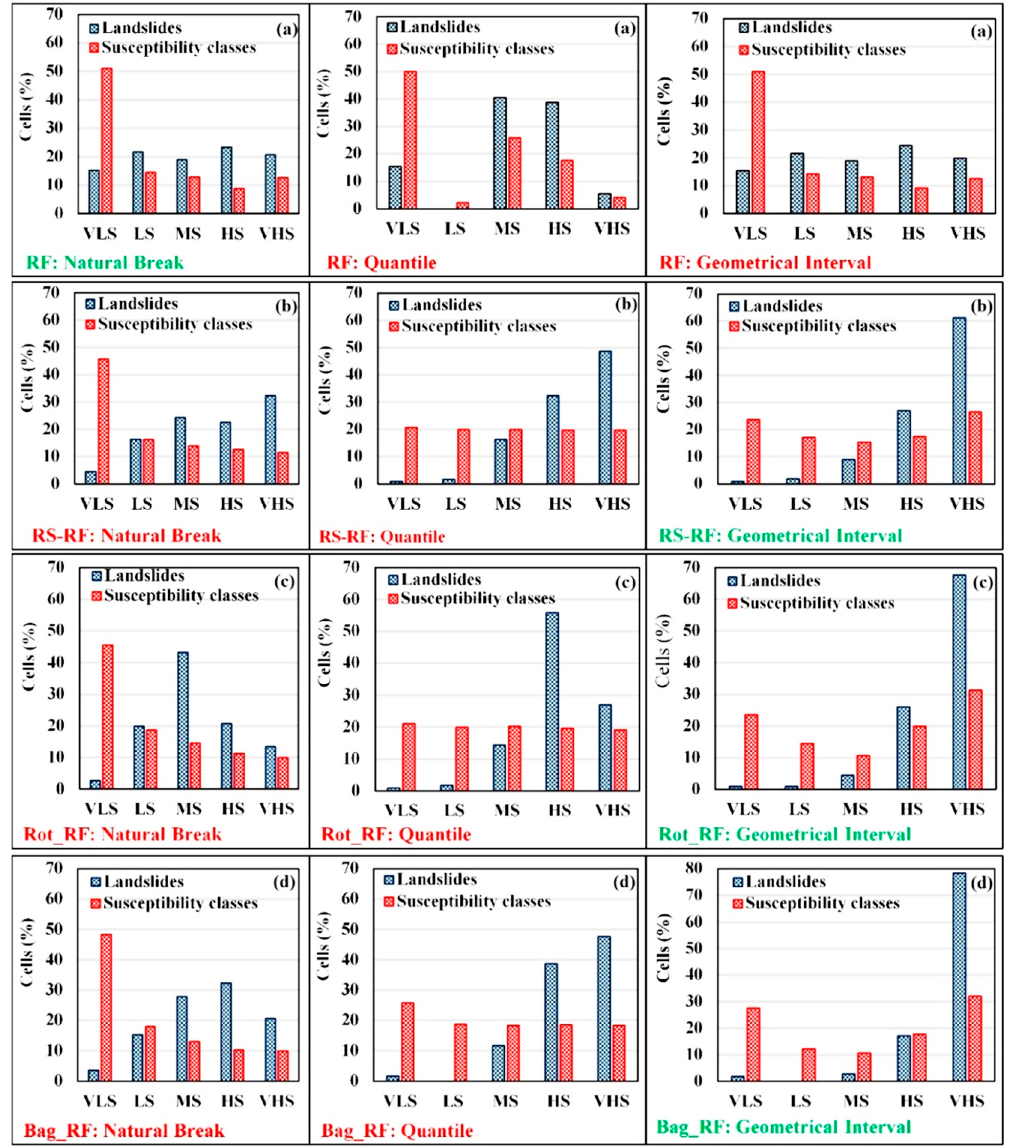
Figure 5. Histograms of all models used to prepare the landslides susceptibility maps using three classification methods (Natural break, Quantile, Geometrical interval): ( a ) RF, ( b ) RS-RF, ( c ) Rot-RF, ( d ) Bag-RF